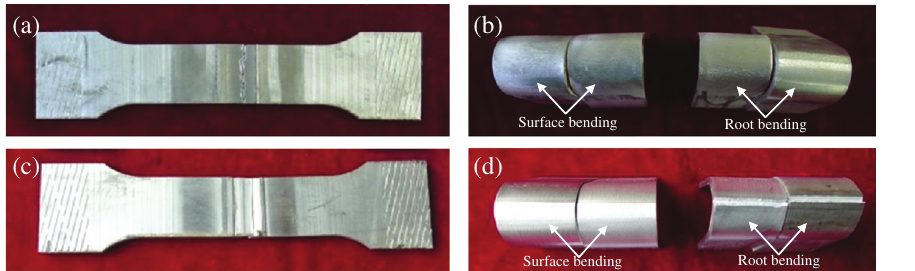
Figure 10: Specimens of tensile tests and bending tests of joints under different welding speeds and the 1 mm wide strip: (a) test specimens and (b) bending specimens under the welding speed of 50 mm/min; (c) test specimens and (d) bending specimens under the welding speed of 200